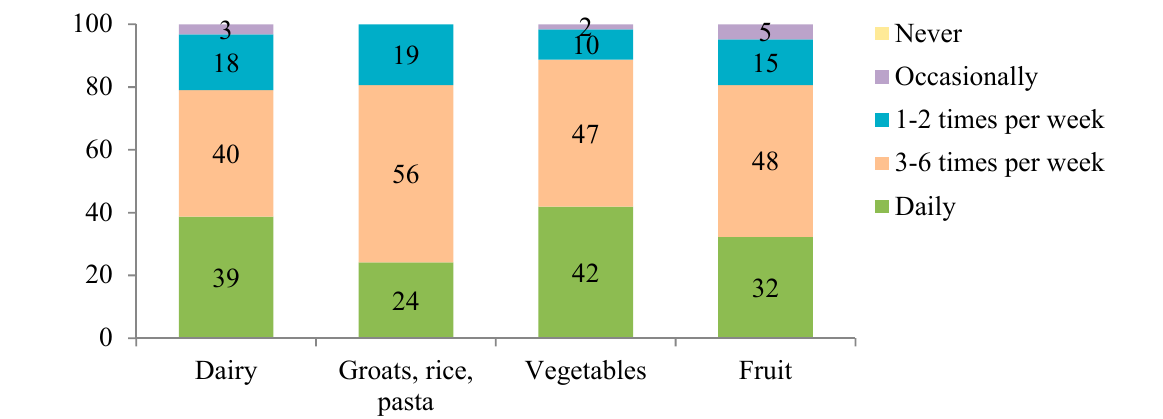
Figure 1. The most often consumed food groups ( n = 62).